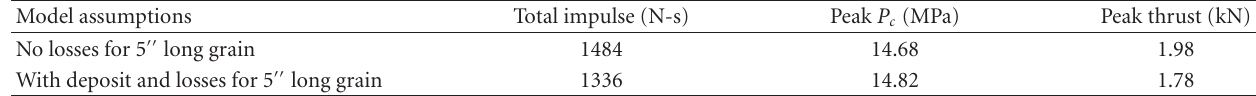
Table 3: Modeling summary for 5 (cid:4)(cid:4) long grain.